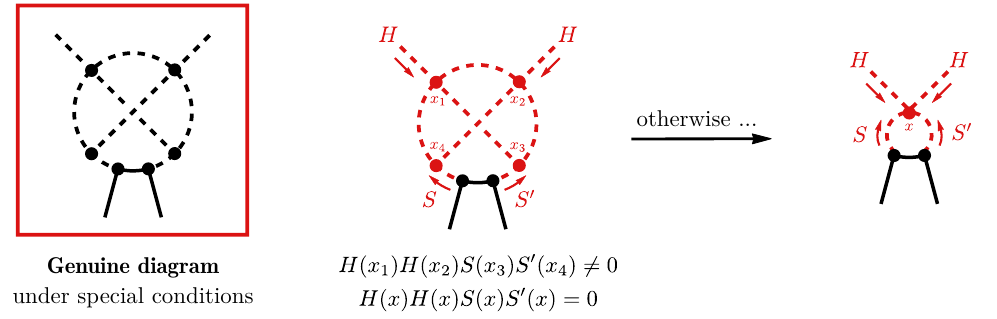
Figure 16 . Topology 54 has only one diagram associated to it (shown here inside the box on the left). This diagram is only genuine under special conditions, in particular the two scalars interacting with the fermion line ( S and S 0 ) must be a Higgs H and a scalar (cid:30) D (cid:17) ( 1 ; 2 ; (cid:0) 3 = 2). depicted in (cid:12)gure 15 will not exist. Keeping in mind that in the Weinberg operator